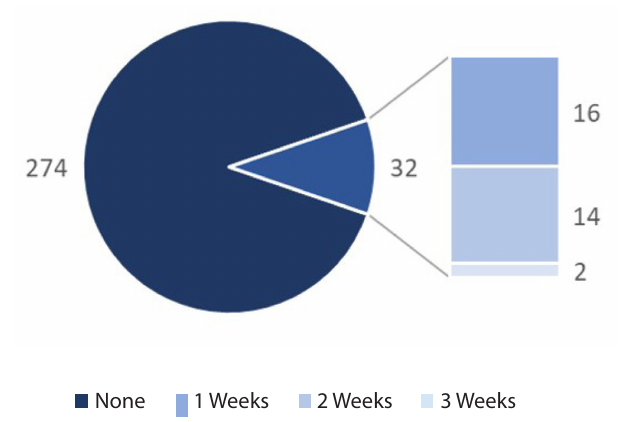
Fig. 1 - The reported length of cardiothoracic placements.